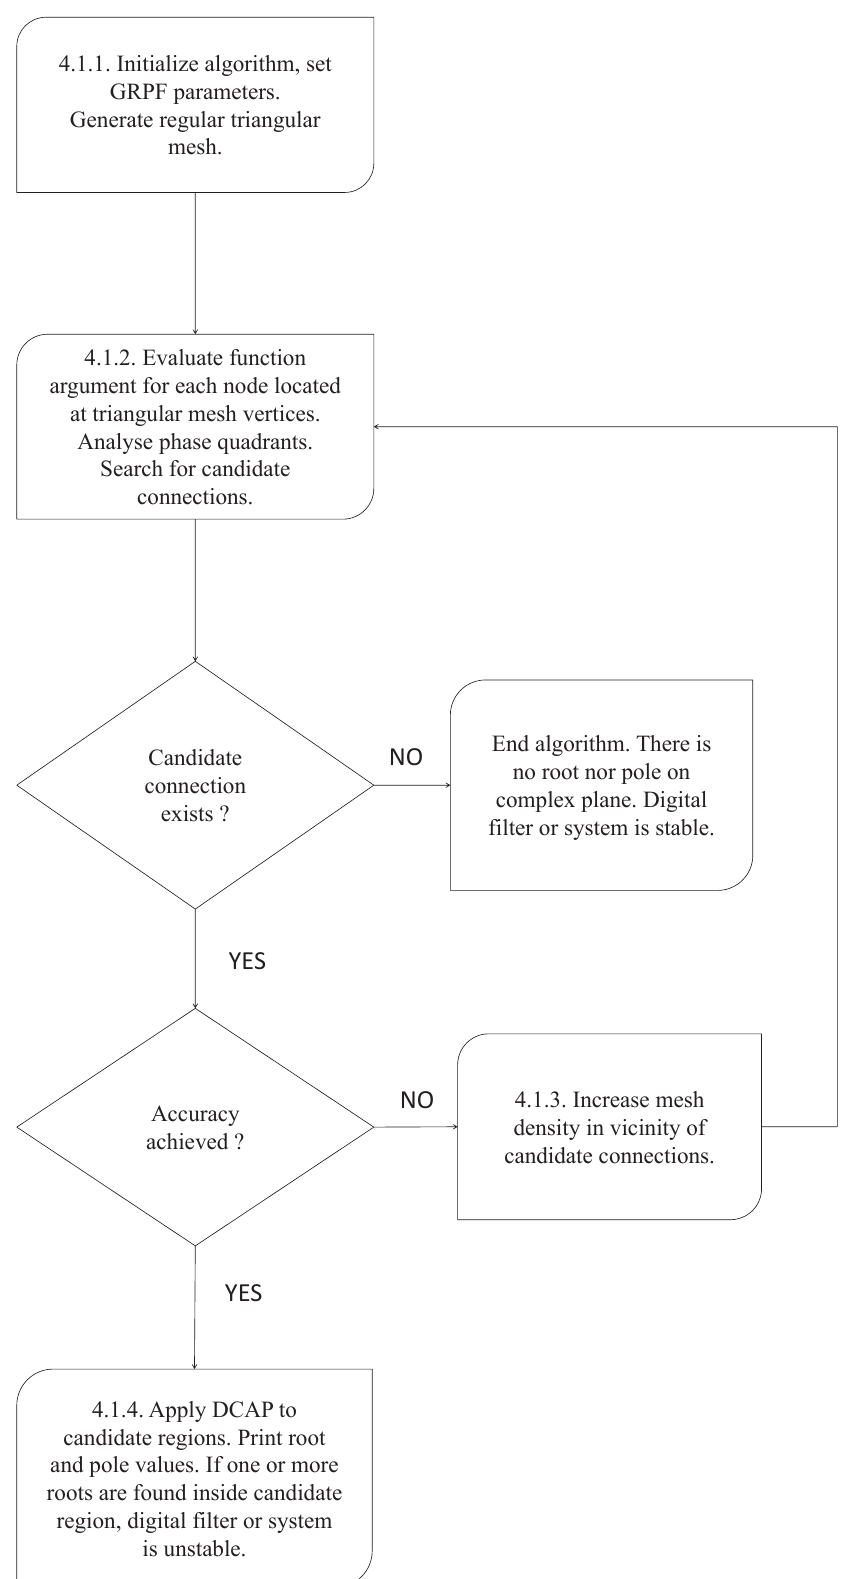
Figure 2. Flowchart of stability test with the global complex roots and poles finding (GRPF)